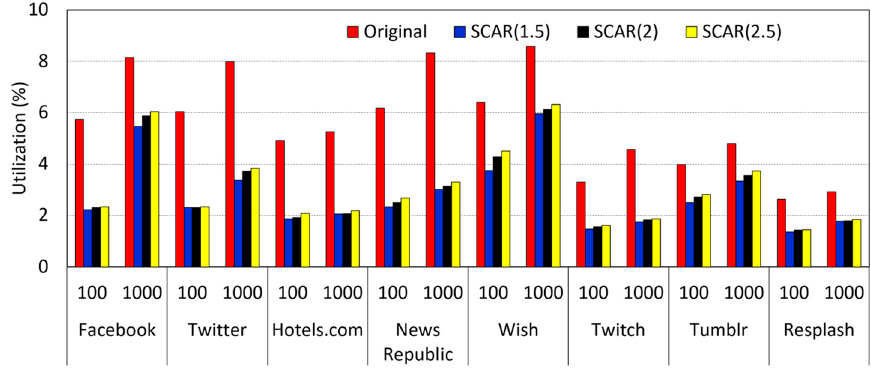
Figure 11. Average CPU utilization.